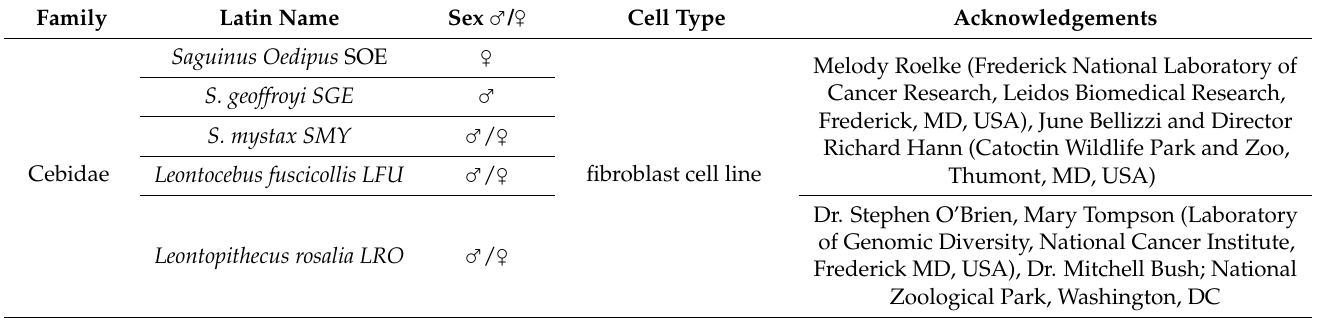
Table 1. Information for all specimens analysed in the current